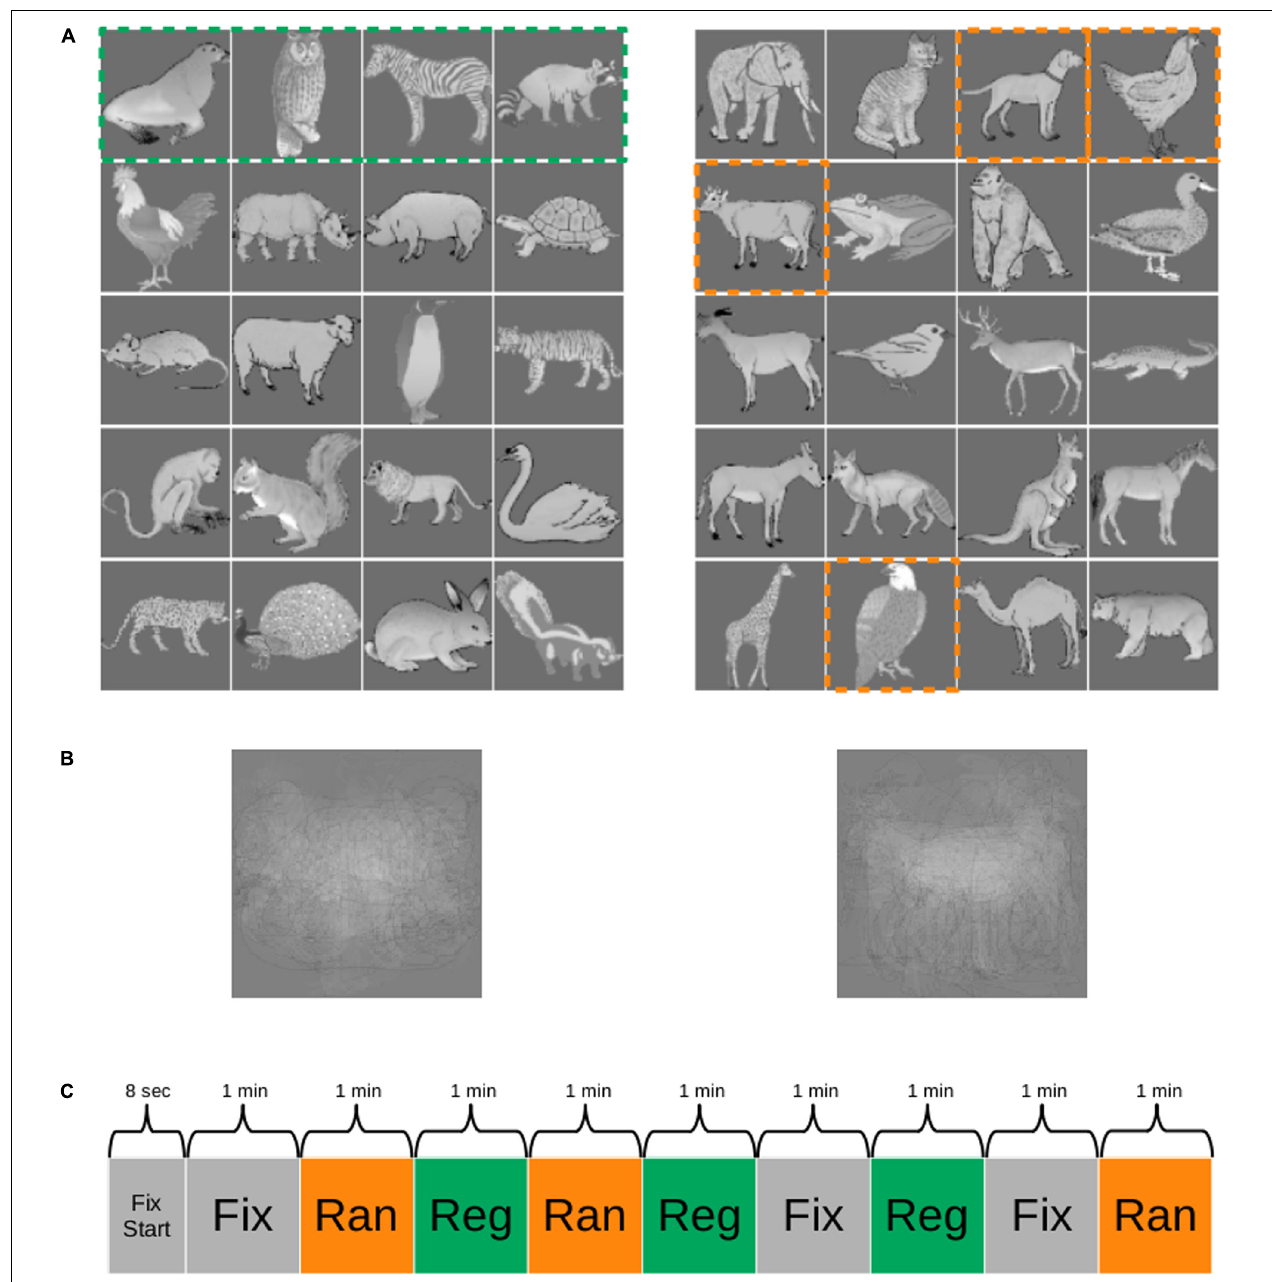
FIGURE 1 | Stimuli and functional MRI (fMRI) paradigm. (A) One group of images (e.g., images of the left panel) was employed as the regular sequence in one monkey and as the random sequence in the other monkey and vice versa . The images were presented in quartets (stippled green box in the left panel), resulting in five fixed quartets (rows) for the regular sequence. The random sequences were obtained by selecting for each presented quartet at random one of the five images at each position [column in (A) , right panel] of the quartet. The dashed orange outlines indicate one such possible selection. In this example, the quartet would be “cow, eagle, dog, hen.” For more details, see “Materials and Methods.” (B) Mean of the images for each of the two groups. (C) Example of a run during scanning. Reg, regular sequence; Ran, random sequence; Fix, fixation only condition; Fix Start, fixation only period at the beginning of the run. The duration of each block is indicated. The order of the conditions was randomized across